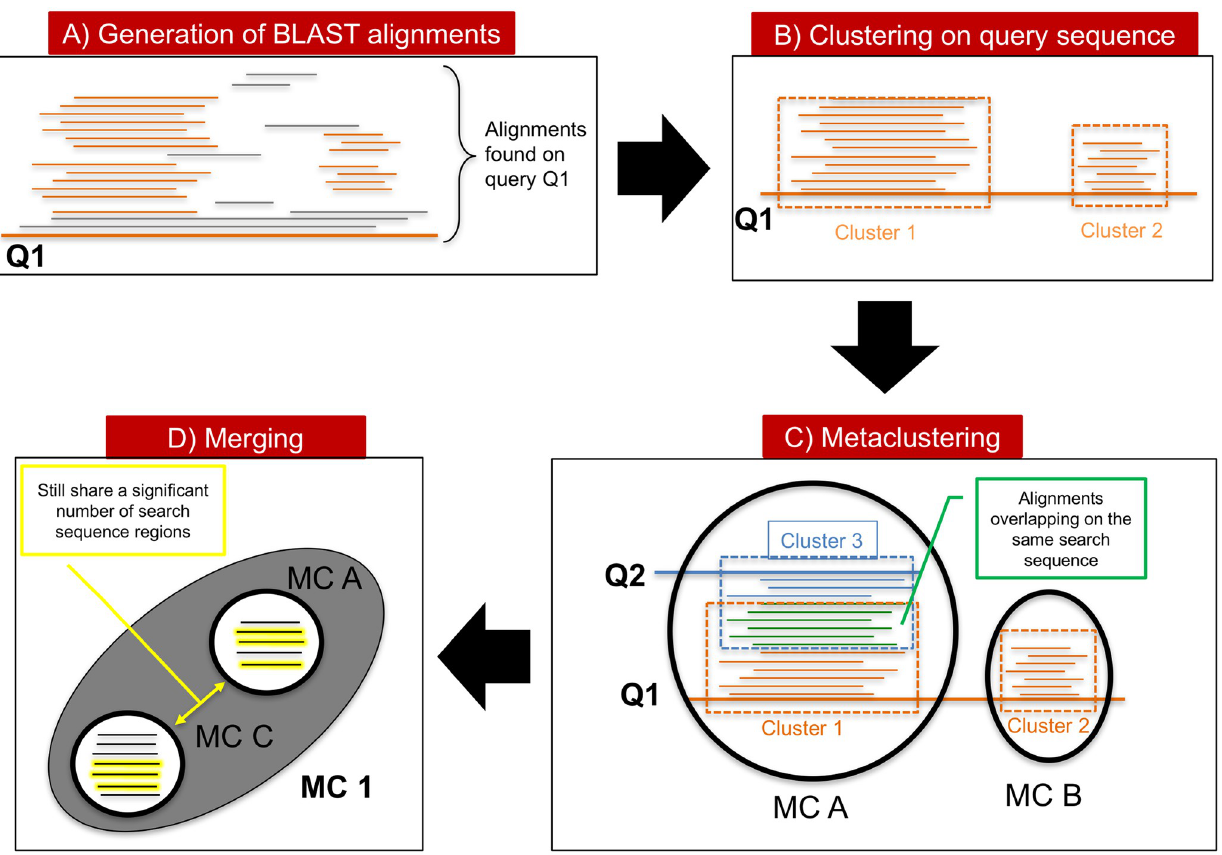
Fig 1. Graphical sketch of the DPCfam workflow. (A) for each query sequence in the reference dataset (UniRef50), we collect all search sequence regions (SSRs) that align to it (BLAST with E-value < 0.1); (B) we use Density Peak Clustering (DPC) to group together SSRs that align to similar portions of the query; (C) primary clusters obtained in (B) for all queries are “metaclustered” (using, again, DPC) according to the number of SSRs they share; (D) finally, metaclusters that still share a significant number of SSRs undergo a further merging step. Material from: ‘Russo et al., Density Peak clustering of protein sequences associated to a Pfam clan reveals clear similarities and interesting differences with respect to manual family annotation, BMC Bioinformatics, published 2021, BioMed Central Ltd.’ [16].